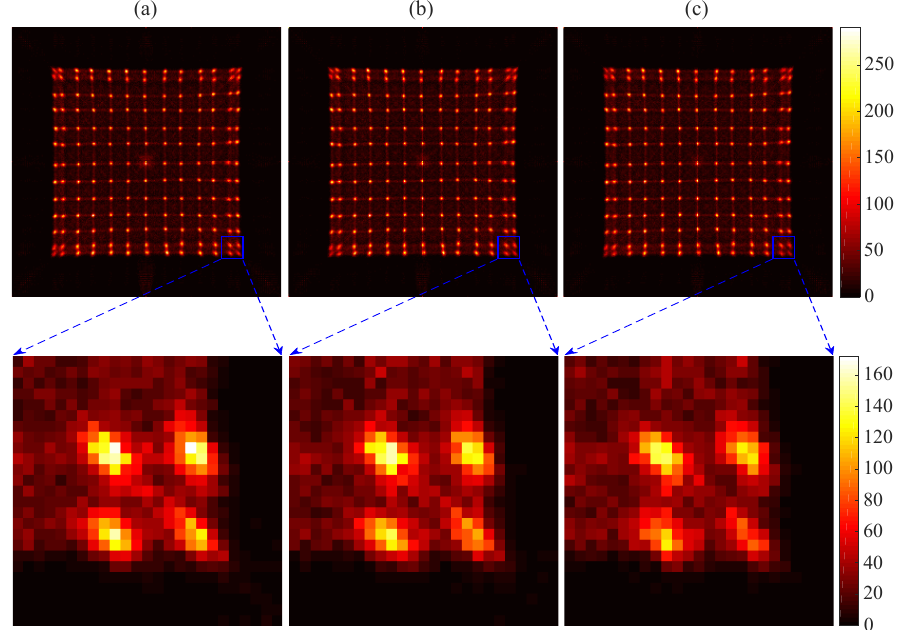
Figure 12. The flood histograms obtained at temperatures of 5 ◦ C ( a ), 15 ◦ C ( b ), and 25 ◦ C ( c ). The four spots at the edge of the flood histogram are given to observe the differences of the